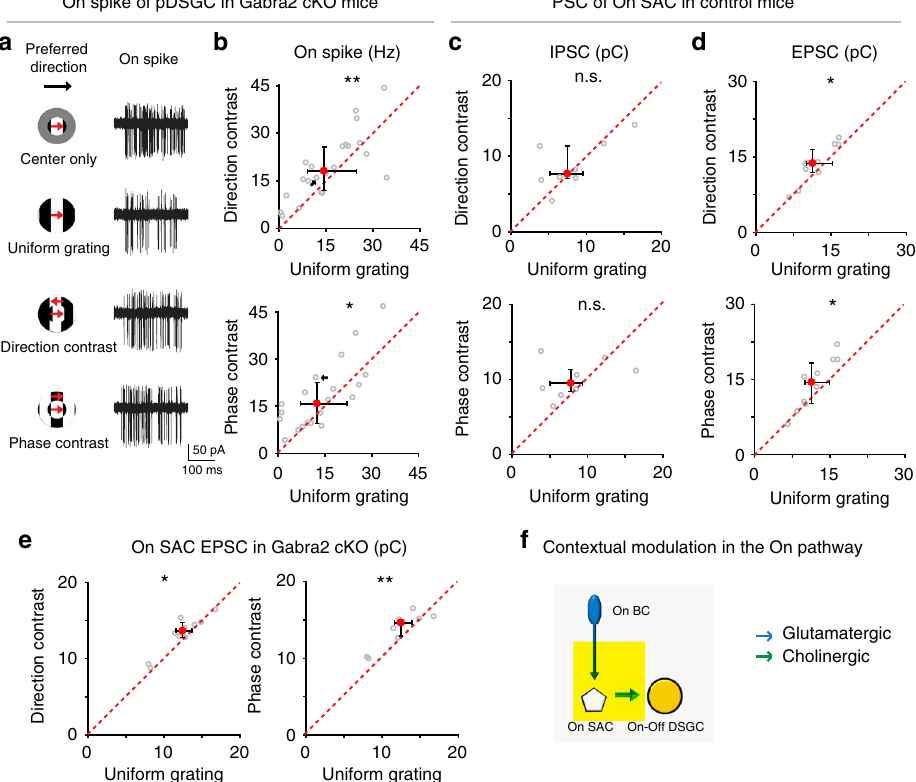
Fig. 5 The contextual sensitivity of pDSGCs and On SACs is mediated by the excitatory inputs but not inhibitory inputs onto On SACs. a On spike traces of an example pDSGC from a Gabra2 cKO mouse under different stimulus conditions. See also Supplementary Fig. 6a for example EPSC traces from a pDSGC in Gabra2 cKO mouse. b Scatter plots compare pDSGC On spike fi ring rate during uniform grating versus compound gratings in Gabra2 cKO mice. Direction-contrast vs uniform grating: n = 22 cells from 12 mice, ** p = 0.0094; Phase-contrast vs uniform grating: n = 20 cells from 12 mice, * p = 0.048. Wilcoxon signed-rank tests were used in this and subsequent scatter plots. See also Supplementary Fig. 6b for comparison of On EPSC charge transfer of pDSGCs in Gabra2 cKO mice. c Scatter plots of On SAC inhibitory charge transfer in control mice, n = 8 cells from 4 mice. Direction-contrast vs uniform grating: p = 0.95; Phase-contrast vs uniform grating: p = 0.15. d Scatter plots of On SAC excitatory charge transfer in control mice, n = 10 cells from 4 mice. Direction-contrast vs uniform grating: * p = 0.020; Phase-contrast vs uniform grating: * p = 0.027. e Scatter plots of On SAC excitatory charge transfer in Gabra2 KO mice, n = 10 cells from 2 mice. Direction-contrast vs uniform grating: * p = 0.037; Phase-contrast vs uniform grating: ** p = 0.0098. f Schematic diagram shows the acetylcholine release of On SAC is contextually modulated by On BC – On SAC excitatory